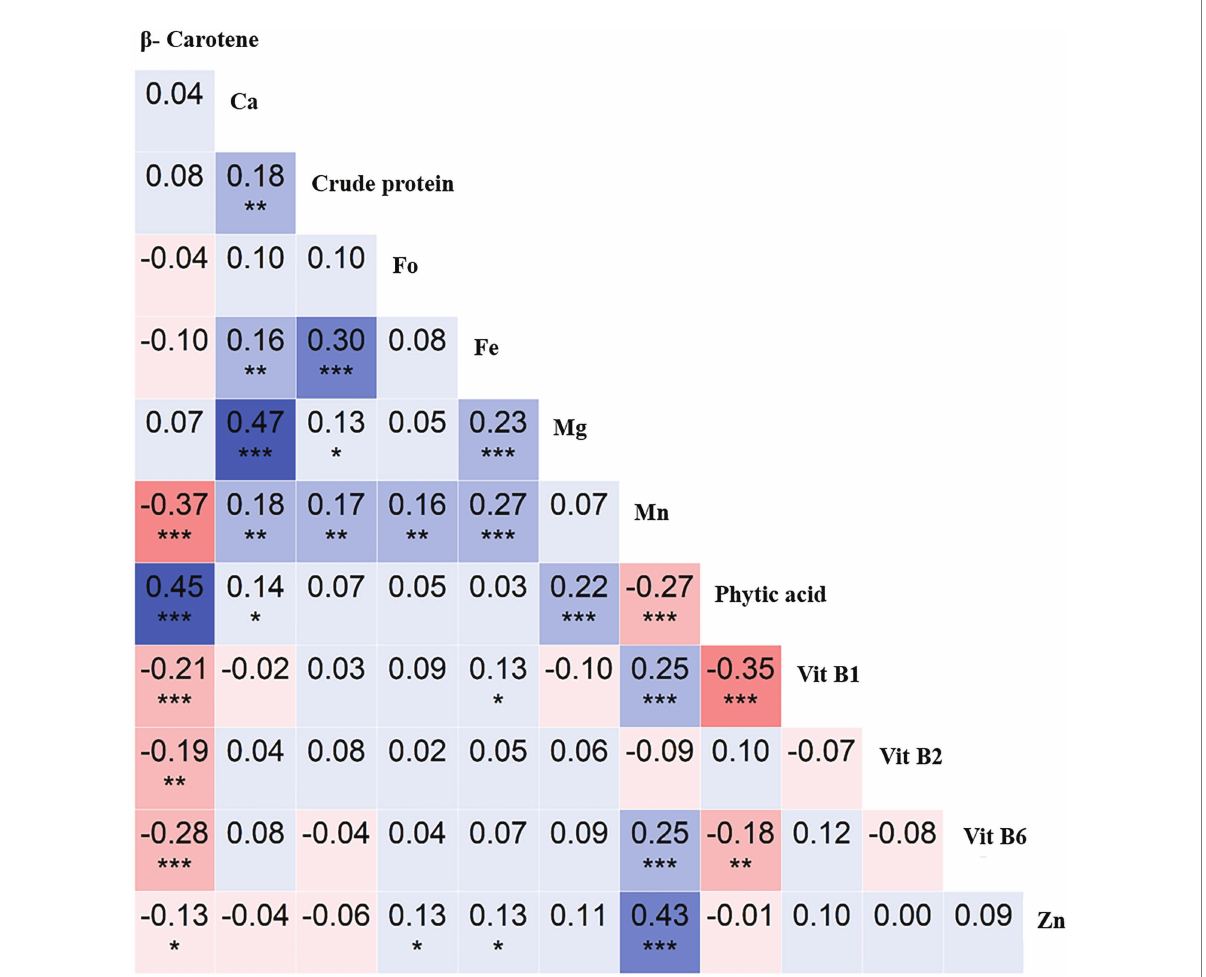
FIGURE 3 Correlation analysis of 12 nutritional traits evaluated using the chickpea reference set. Pearson’s r-values showing correlations between 12 traits [ β -Carotene, calcium (Ca), crude protein, folate (Fo), iron (Fe), magnesium (Mg), manganese (Mn), phytic acid, vitamin B1 (Vit B1), vitamin B2 (Vit B2), vitamin B6 (Vit B6), and zinc (Zn)]. Blue indicates positive correlations, and red indicates negative correlations among traits; color intensity depicts correlation strength. *significant at < 0.05 level, **significant at <0.01 level, *** significant at < 0.001 level, blank for